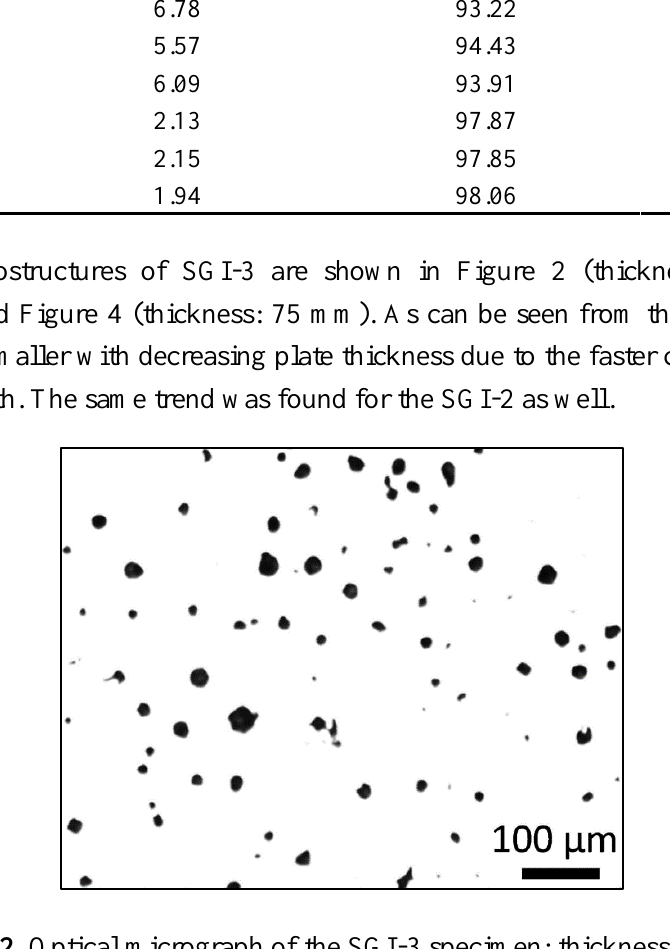
Figure 2. Optical micrograph of the SGI-3 specimen; thickness: 15